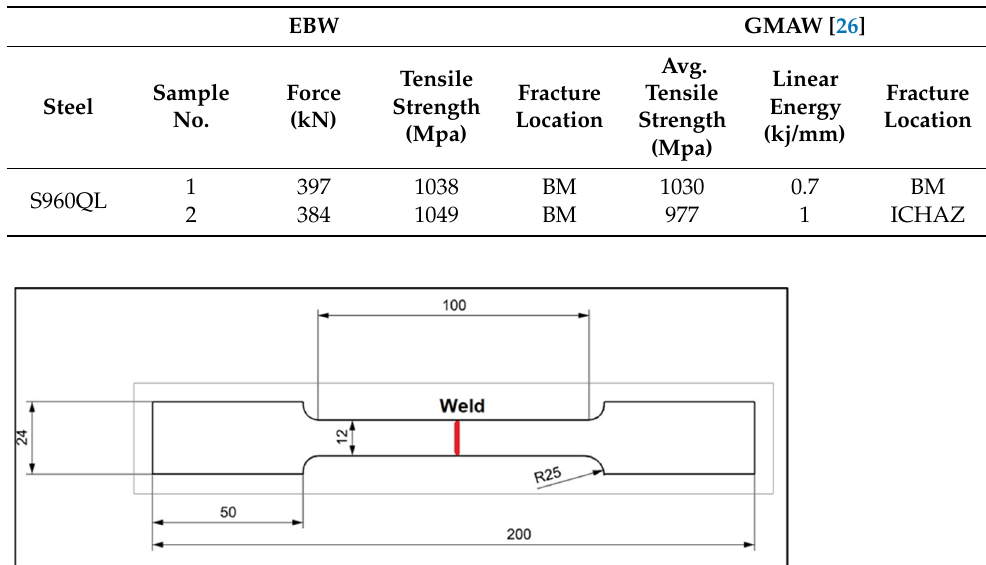
Table 9. Hardness test (HV10) results of GMA-welded S960QL joint.